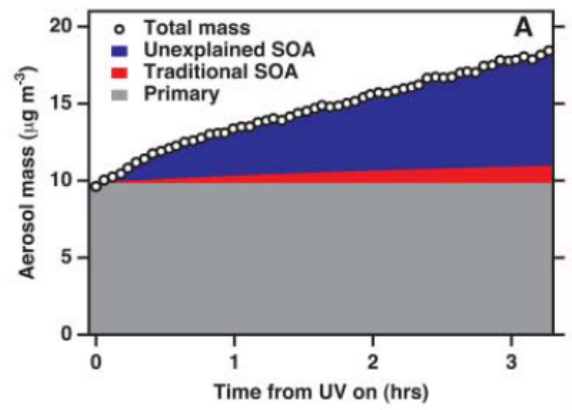
Figure 5. Aerosol particle formation from the photochemical ox- idation of diesel exhaust in an environmental chamber. The grey area indicates the primary aerosol particle (POA + other species). The red area shows the upper-bound estimate of the contribution of known SOA precursors to the suspended aerosol particle mass, leaving behind a large fraction that is not accounted for (blue area) (Robinson et al.,